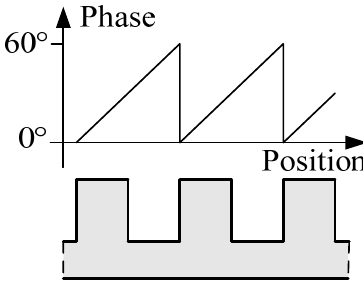
Figure 3. The phase requirement at a large joint